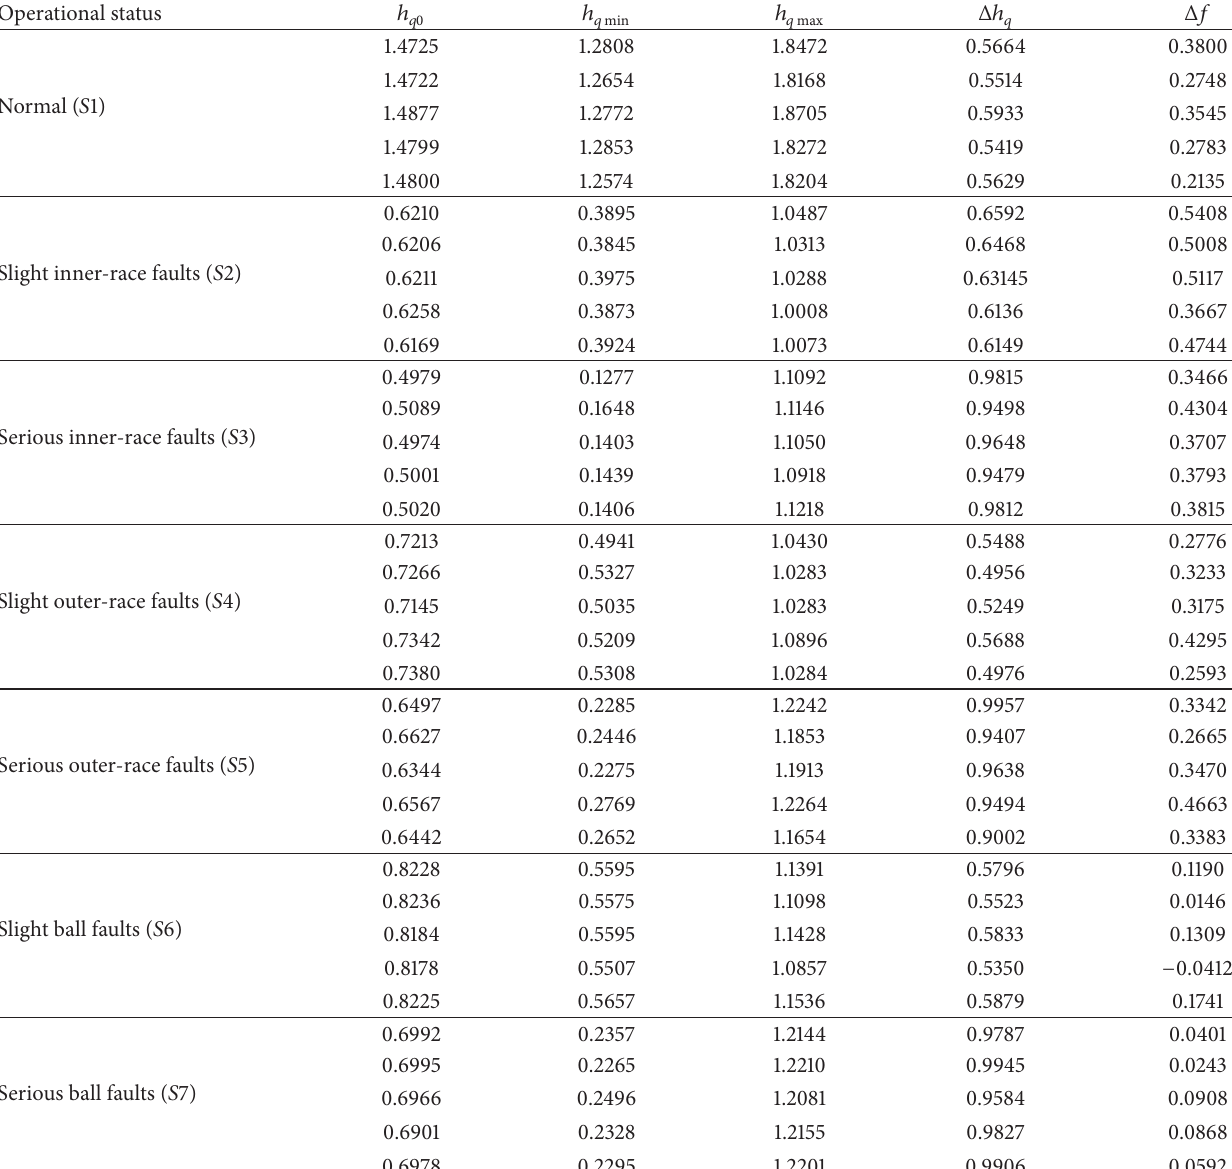
Table 2: The MFDFA features of seven vibration